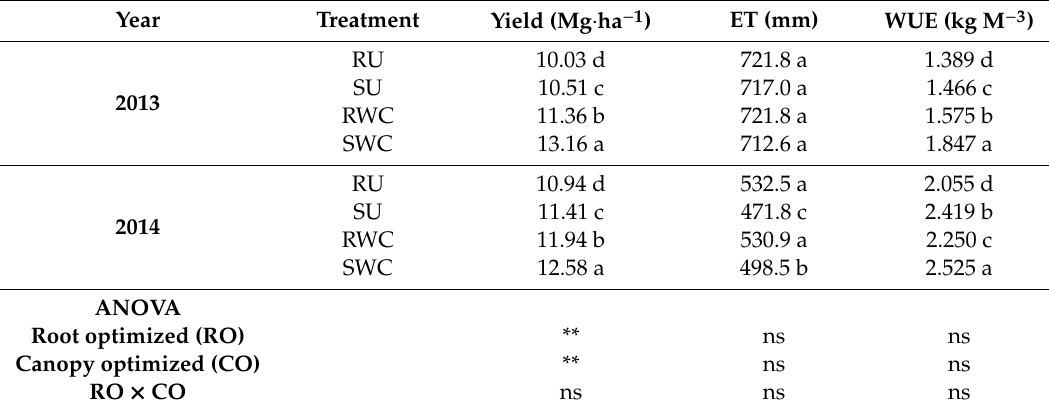
Table 3. Yield, yield components, evapotranspiration (ET), and water use e ffi ciency (WUE) under the di ff erent cultivation modes in 2013 and